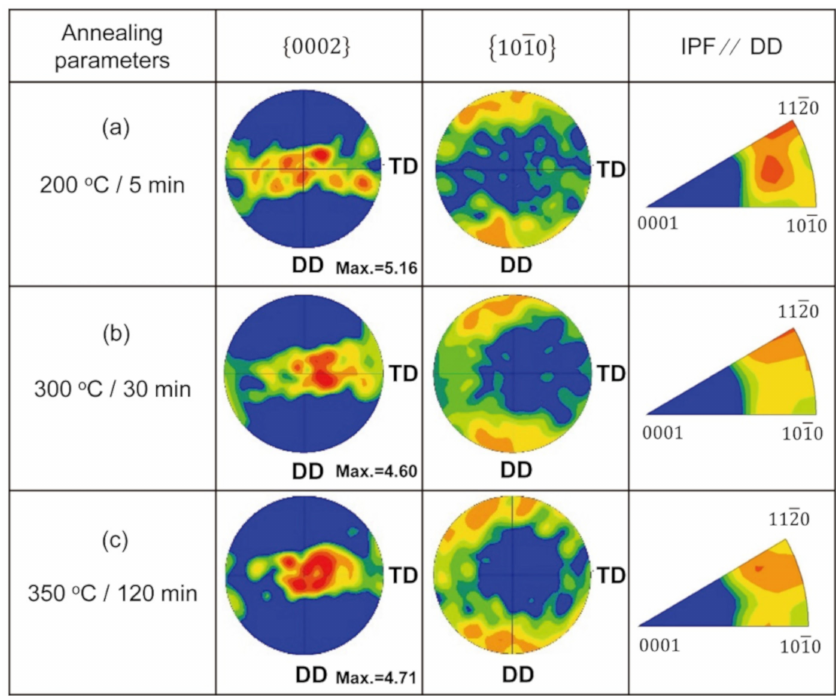
Figure 7. Texture evolution showing PF and IPF of pure Mg wire under di ff erent annealing treatments.